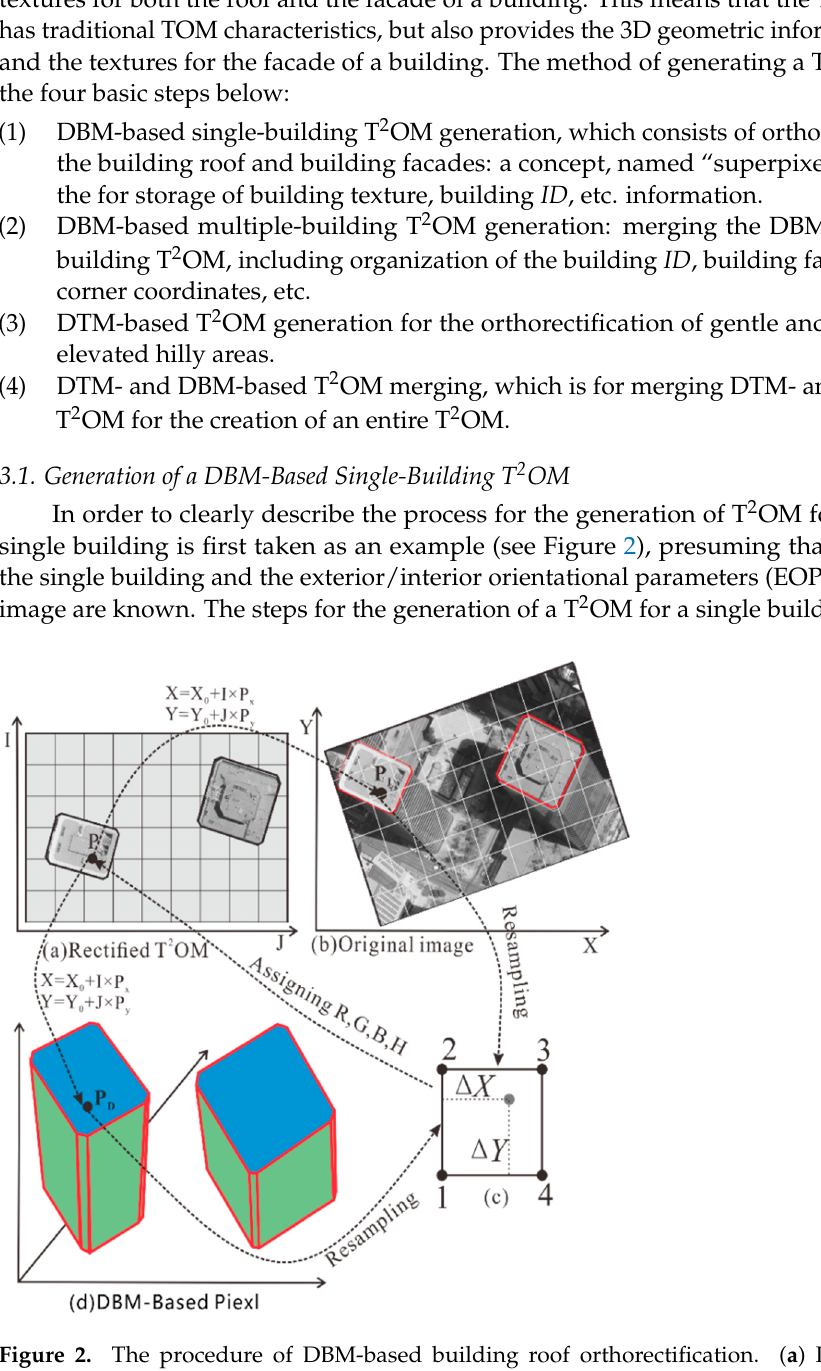
Figure 2. The procedure of DBM-based building roof orthorectification. ( a ) Rectified T 2